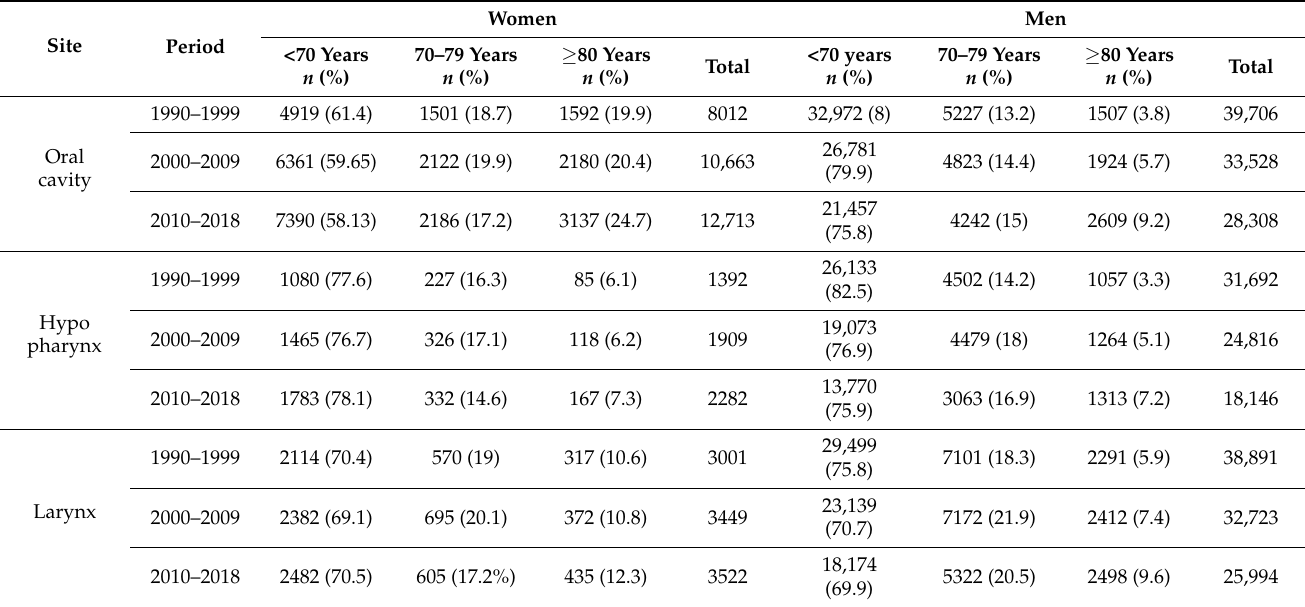
Table 2. The proportion of patients with oral cavity, hypopharynx, and larynx cancers by age and